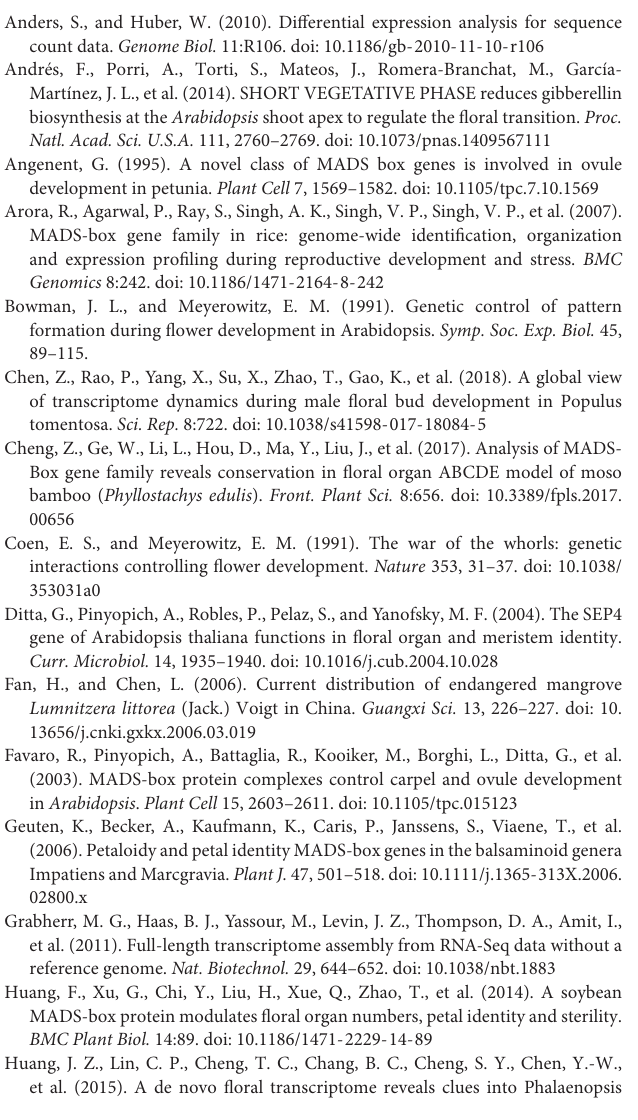
Supplementary Figure 5 | The biological pathways of L. littorea flower unigenes against the KEGG database. Supplementary Figure 6 | DEGs in different column development stages between L-1 and L-2. Supplementary Figure 7 | Functional KEGG pathway annotation of the DEGs of L. littorea . Supplementary Table 1 | Primers used in this study. Supplementary Table 2 | Classify the predicted functions of the query GO database. Supplementary Table 3 | DEGs in the materials L-2 vs. L-1. Supplementary Table 4 | KEGG pathway enrichment analysis. Supplementary Table 5 | Sequence of the MADS-Box genes in L. littorea . Supplementary Table 6 | Validation of assembled unigenes by